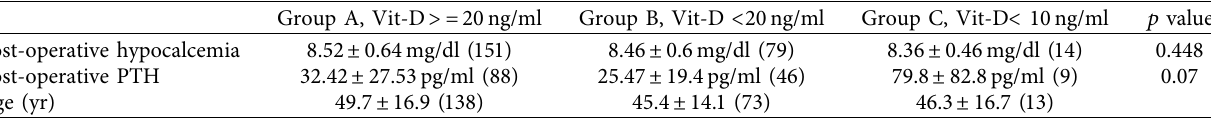
Figure 1: Pearson correlation coefficient between post-surgical calcium and post-surgical parathyroid hormone was 0.102 indicating a weak correlation. Table 3: Relationship between pre-operative vitamin D levels and post-operative hypocalcemia and